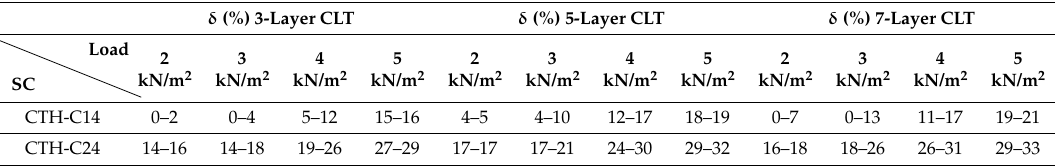
δ is the relative difference and SC is the strength class.